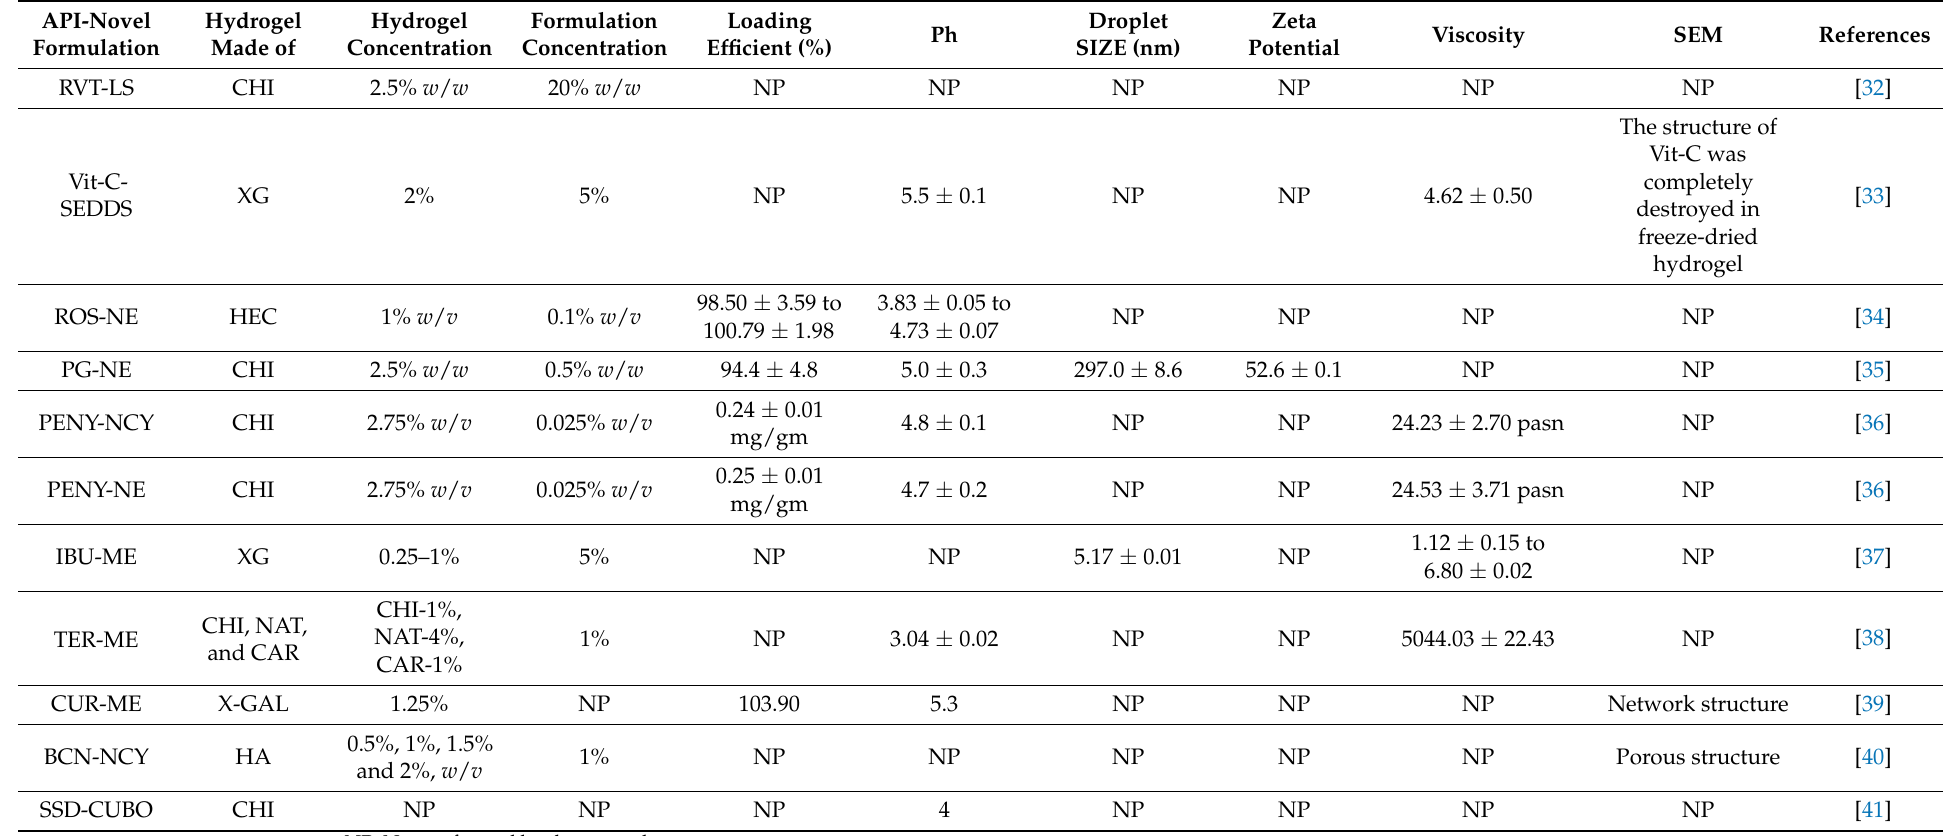
Table 3. Physical evaluation studies for novel hydrogel formulation prepared with natural gelling